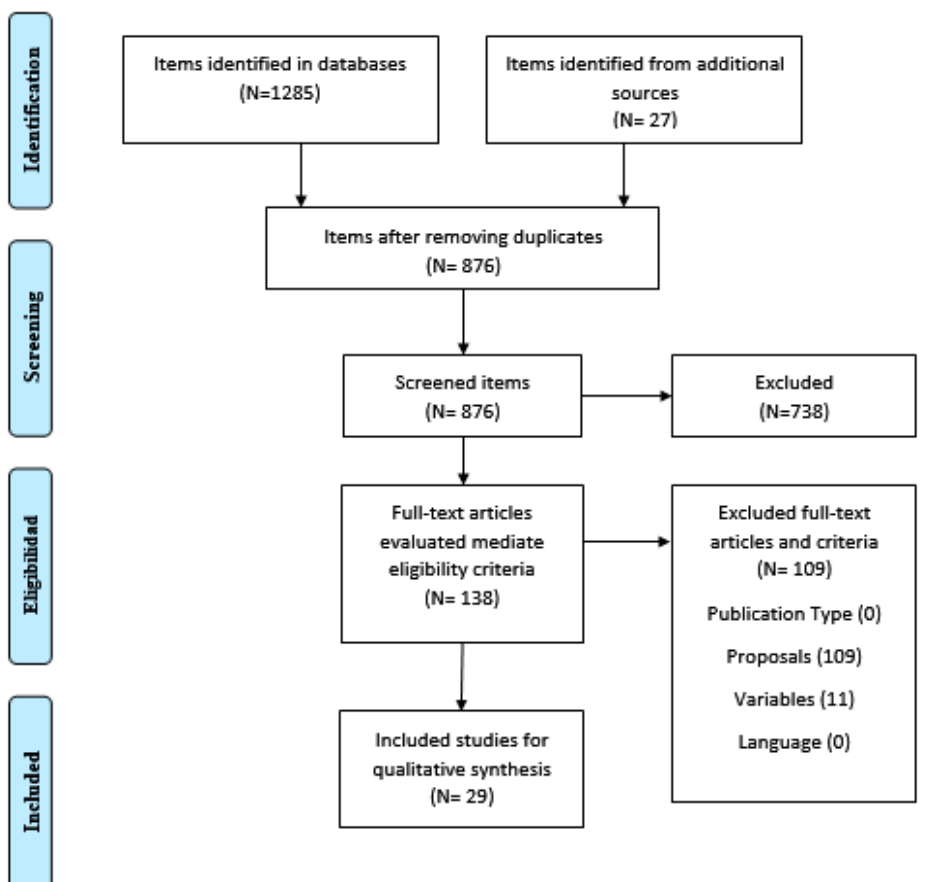
Figure 1. Flowchart of the process of searching and selecting the studies.